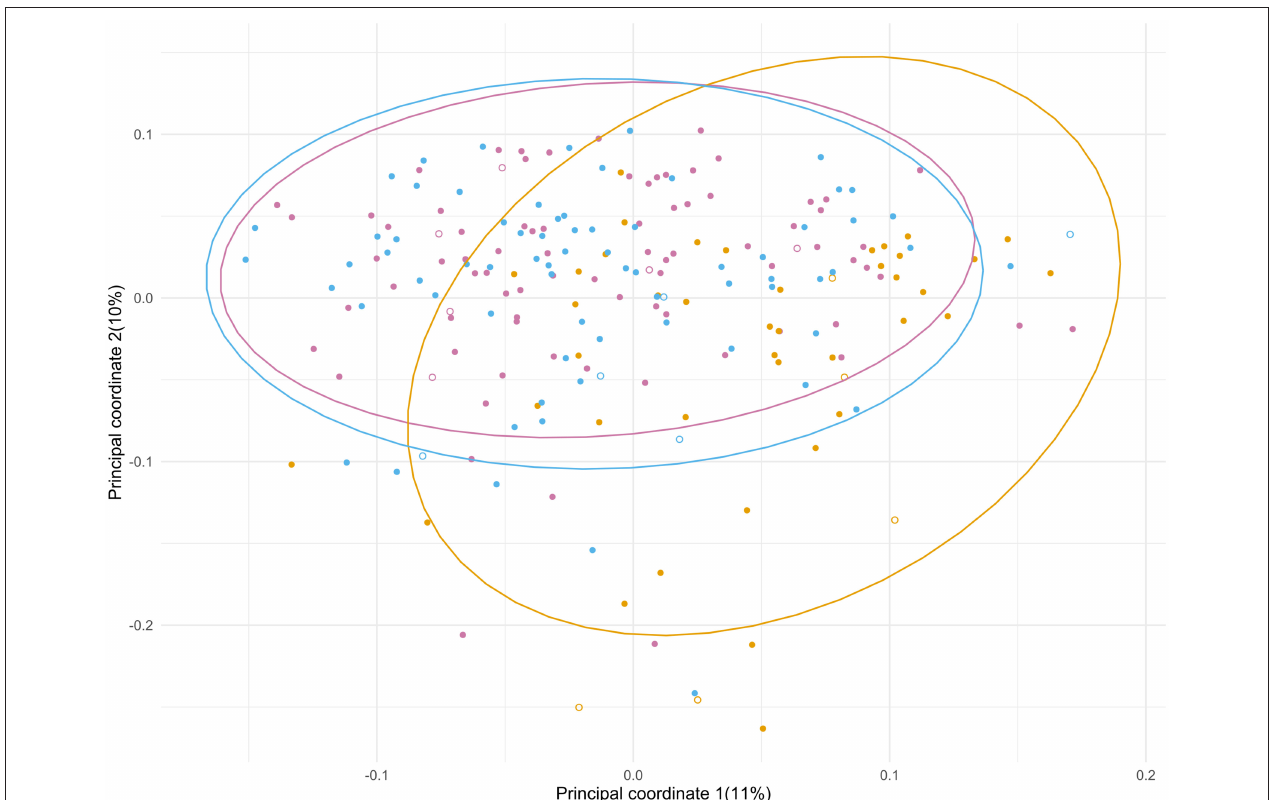
FIGURE 3 | Principal coordinate analysis of the microbial composition of the samples from ICU patients significantly changed over the course of the study period ( p < 0.001). The different time points are depicted in purple (T1), yellow (T2) and blue (T3). Patients who did (7) and did not (90) receive SDD treatment are indicated with open and closed symbols,